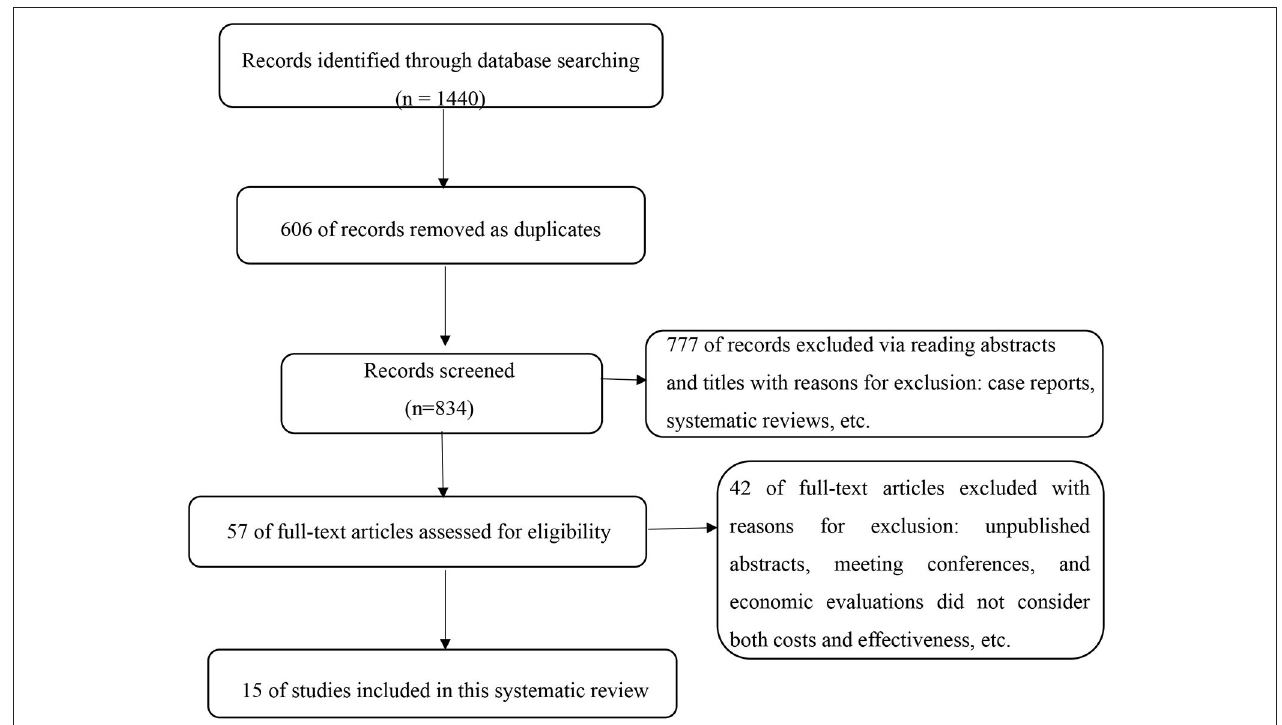
FIGURE 1 | The process of selecting eligible articles for further